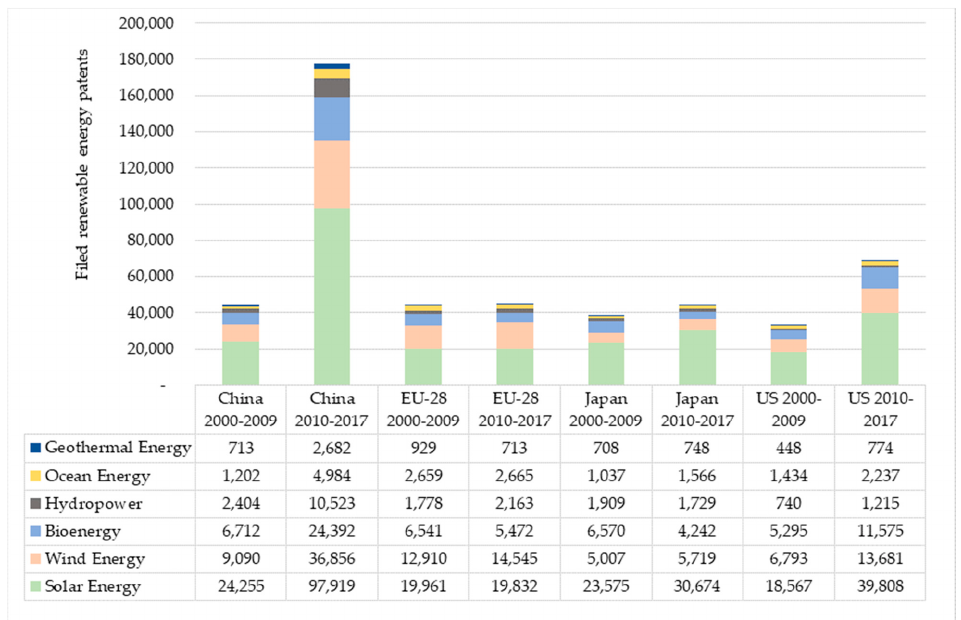
Figure 5. Renewable energy patents by technologies in the China, the EU ‐ 28, Japan and US from 2000 to 2017 (based on [56]).